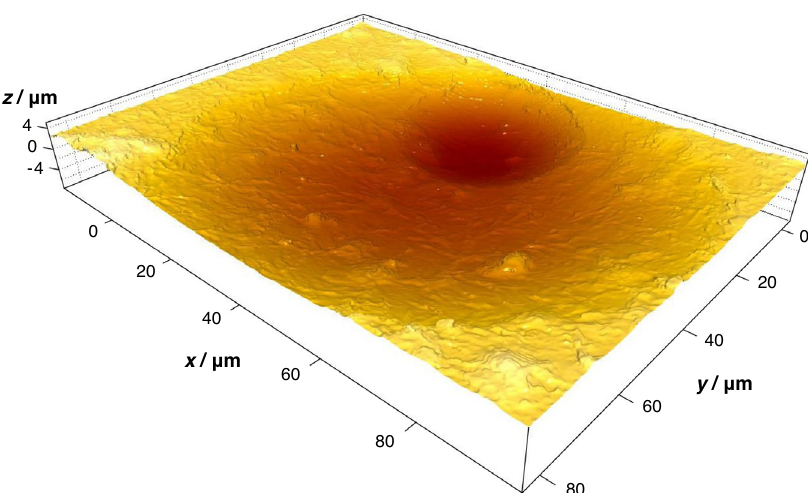
Fig. 7 High-resolution surface detail of a PET fi lm reacted for 24 h. This CM image demonstrates how the crater-type surface is steadily reproduced by the formation of new pits within fading pits of a former generation.